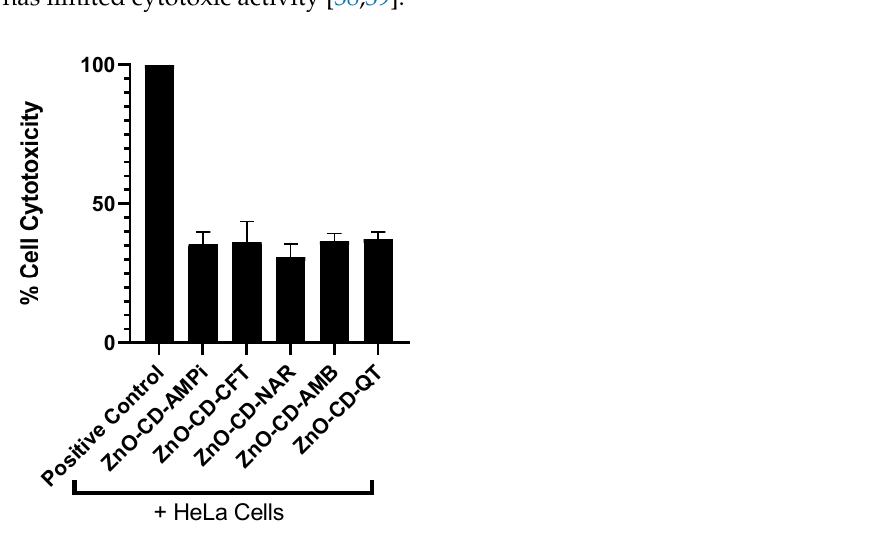
Figure 2. Limited cytotoxic activity was observed in human cells. Weak cytotoxic activity was determined upon the treatment of confluent monolayers of HeLa cells with the compounds at a concentration of 100 µ g/mL. Table 2. Comparative graph of the amoebicidal effects and toxicity of the compounds. The compounds exhibited significant reductions in B. mandrillaris and N. fowleri viability, while maintaining limited cytotoxicity in human HeLa cells. The results presented below are expressed as percentage (%) of cell viability.